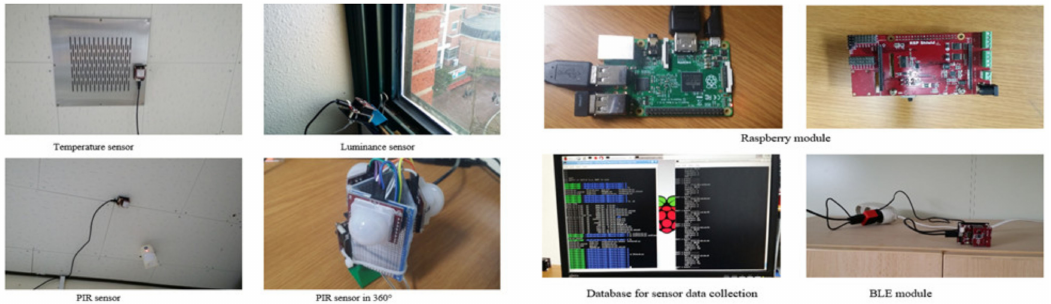
Figure 2. Sensors’ placement for data collection.